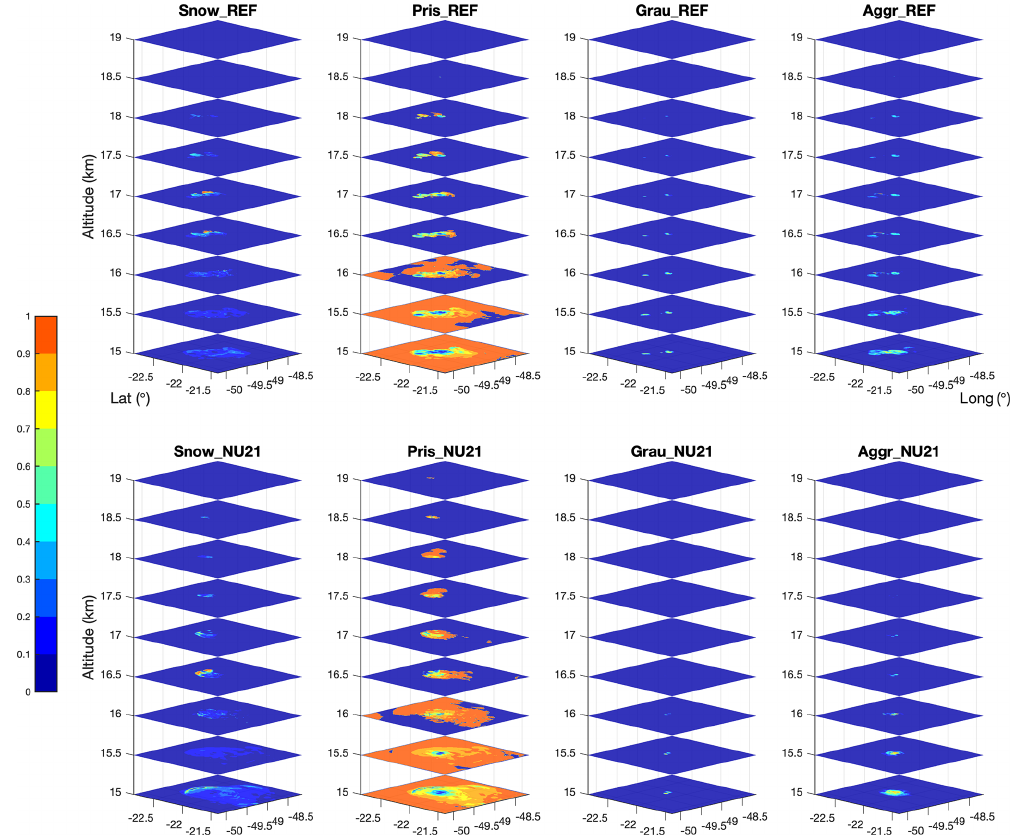
Figure 5. Vertical distribution of horizontal cross section of hydrometeors, viz., snow, pristine ice, graupel, and aggregates, within the third grid, spanning over 15–19km altitude. It is for the ratio of four types of ice hydrometeors against the entire ice content from REF – upper panel, and NU21 – lower panel, shown at 16:15UT. Hail is not included because of its negligible values within the